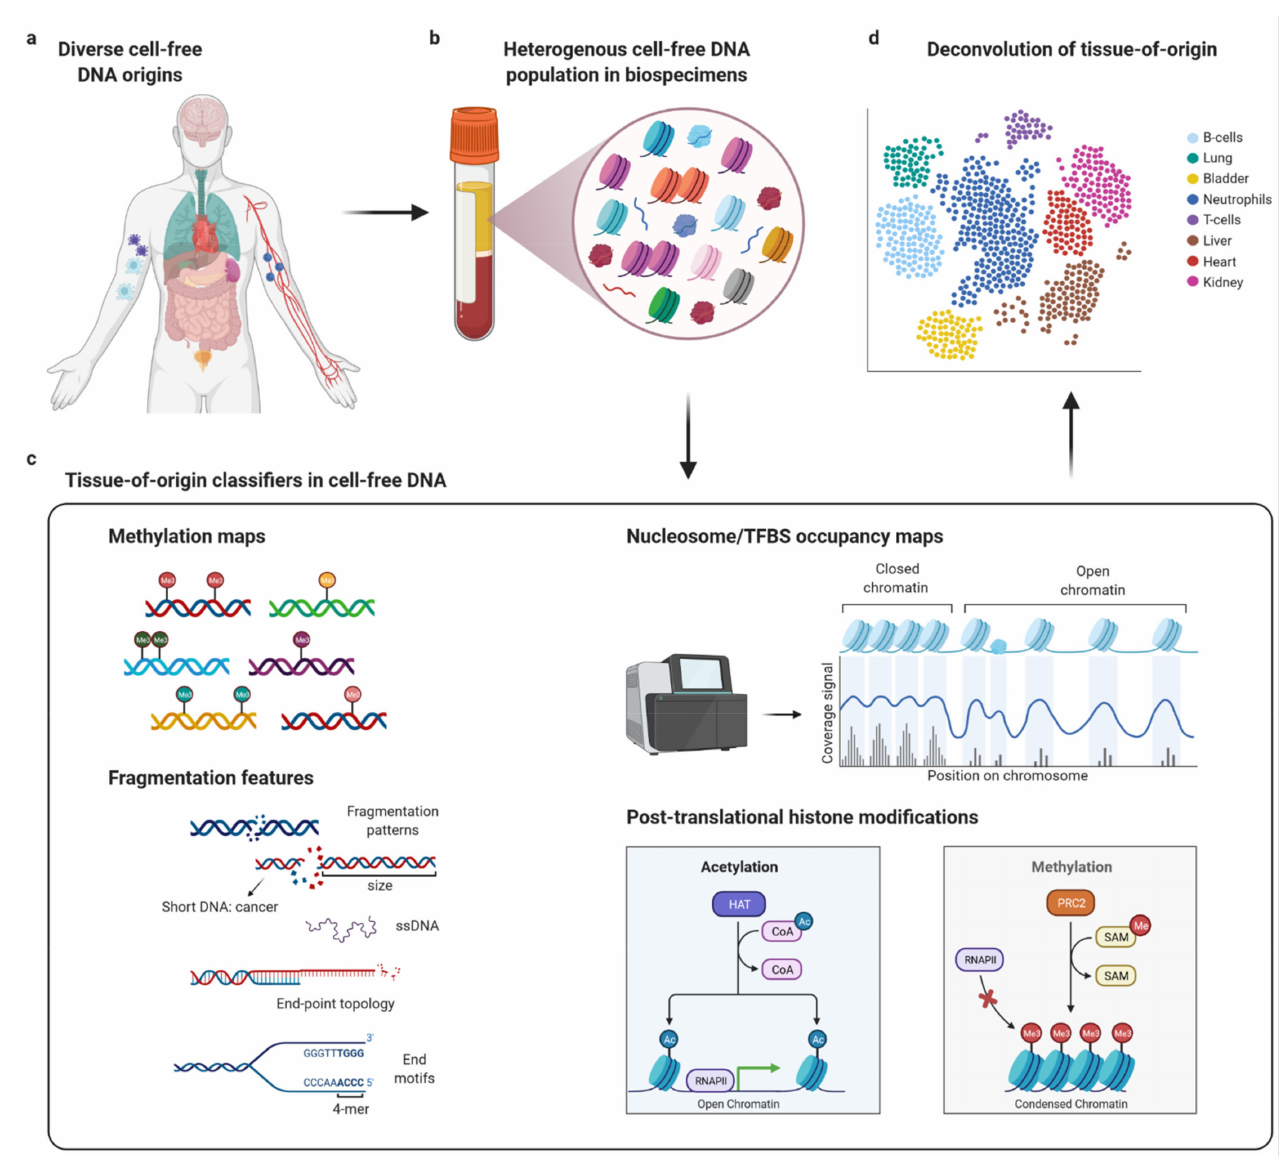
Figure 1. Tissue-of-origin analysis of cell-free DNA. ( a ) Different organs and various cell types release cell-free DNA (cfDNA) into blood plasma. ( b ) This clinical biospecimen represents a highly heterogeneous mixture of cfDNA molecules, often complicating the analytical differentiation between different cfDNA subtypes. ( c ) Multiple different epigenetic characteristics can be employed for tissue-of-origin analysis such as unique methylation patterns, fragmentation profiles and fragment end-points, transcription-factor binding sites occupancy, nucleosome positioning, as well as post- translational histone modifications. ( d ) Analysis of these features poses an analytical challenge, but various approaches developed recently enable determination of tissue-of-origin of individual